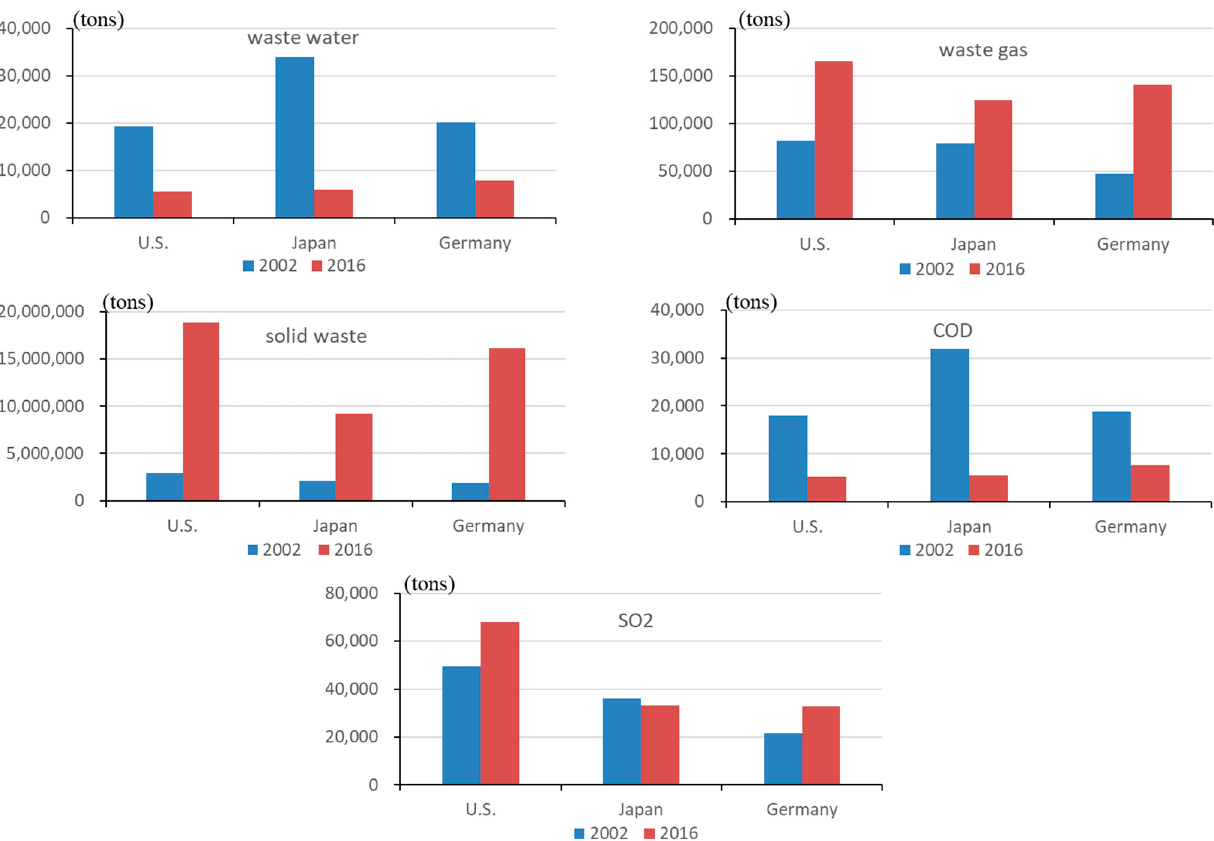
Figure 4. The embodied emission in China’s imports from the US, Japan, and Germany (unit: tons).